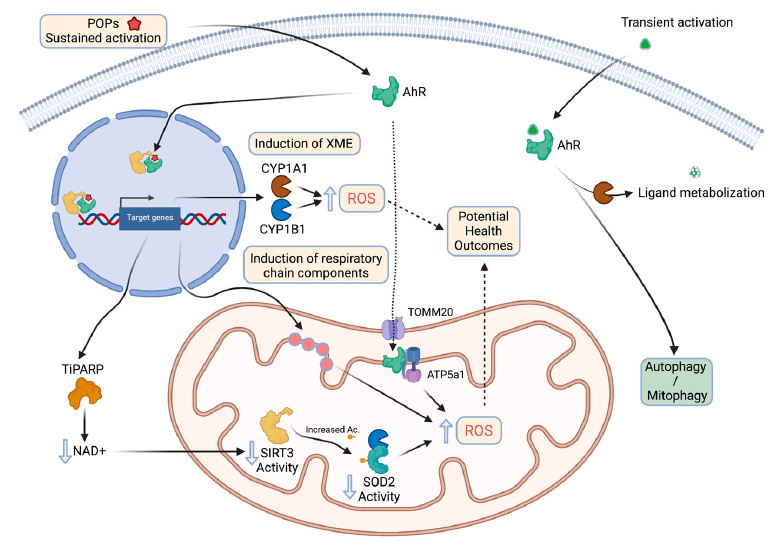
Figure 3. The relationship between AhR chronic vs acute activation by its ligands and mitochondrial functions (created with BioRender.com, accessed on 30 November 2021).